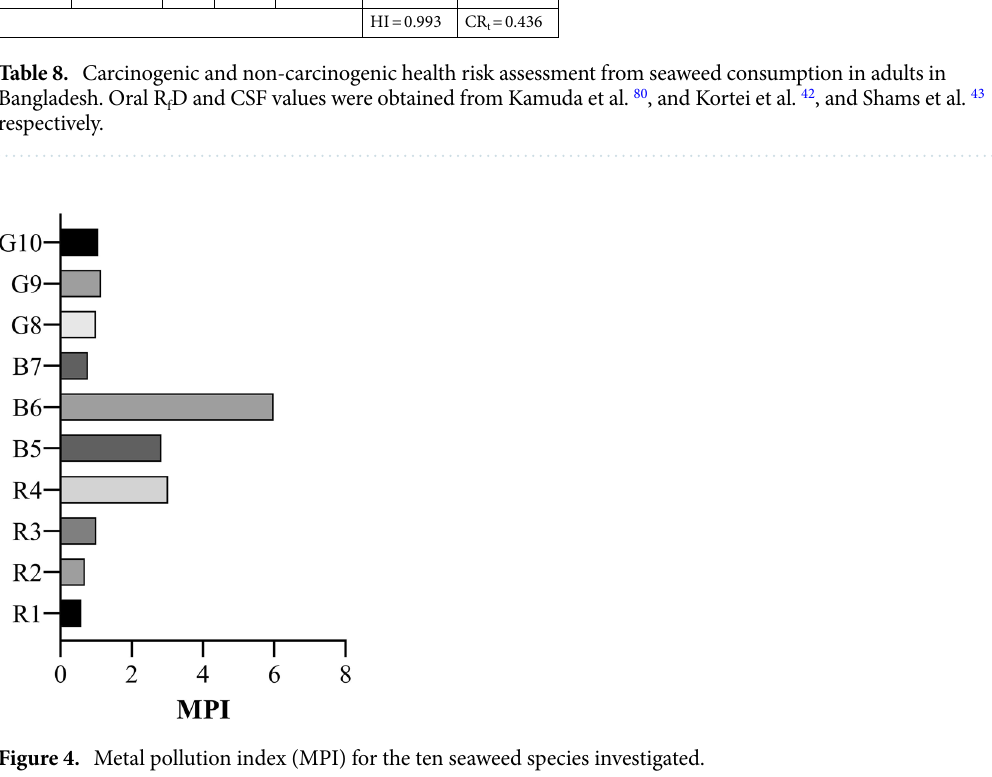
Figure 4. Metal pollution index (MPI) for the ten seaweed species